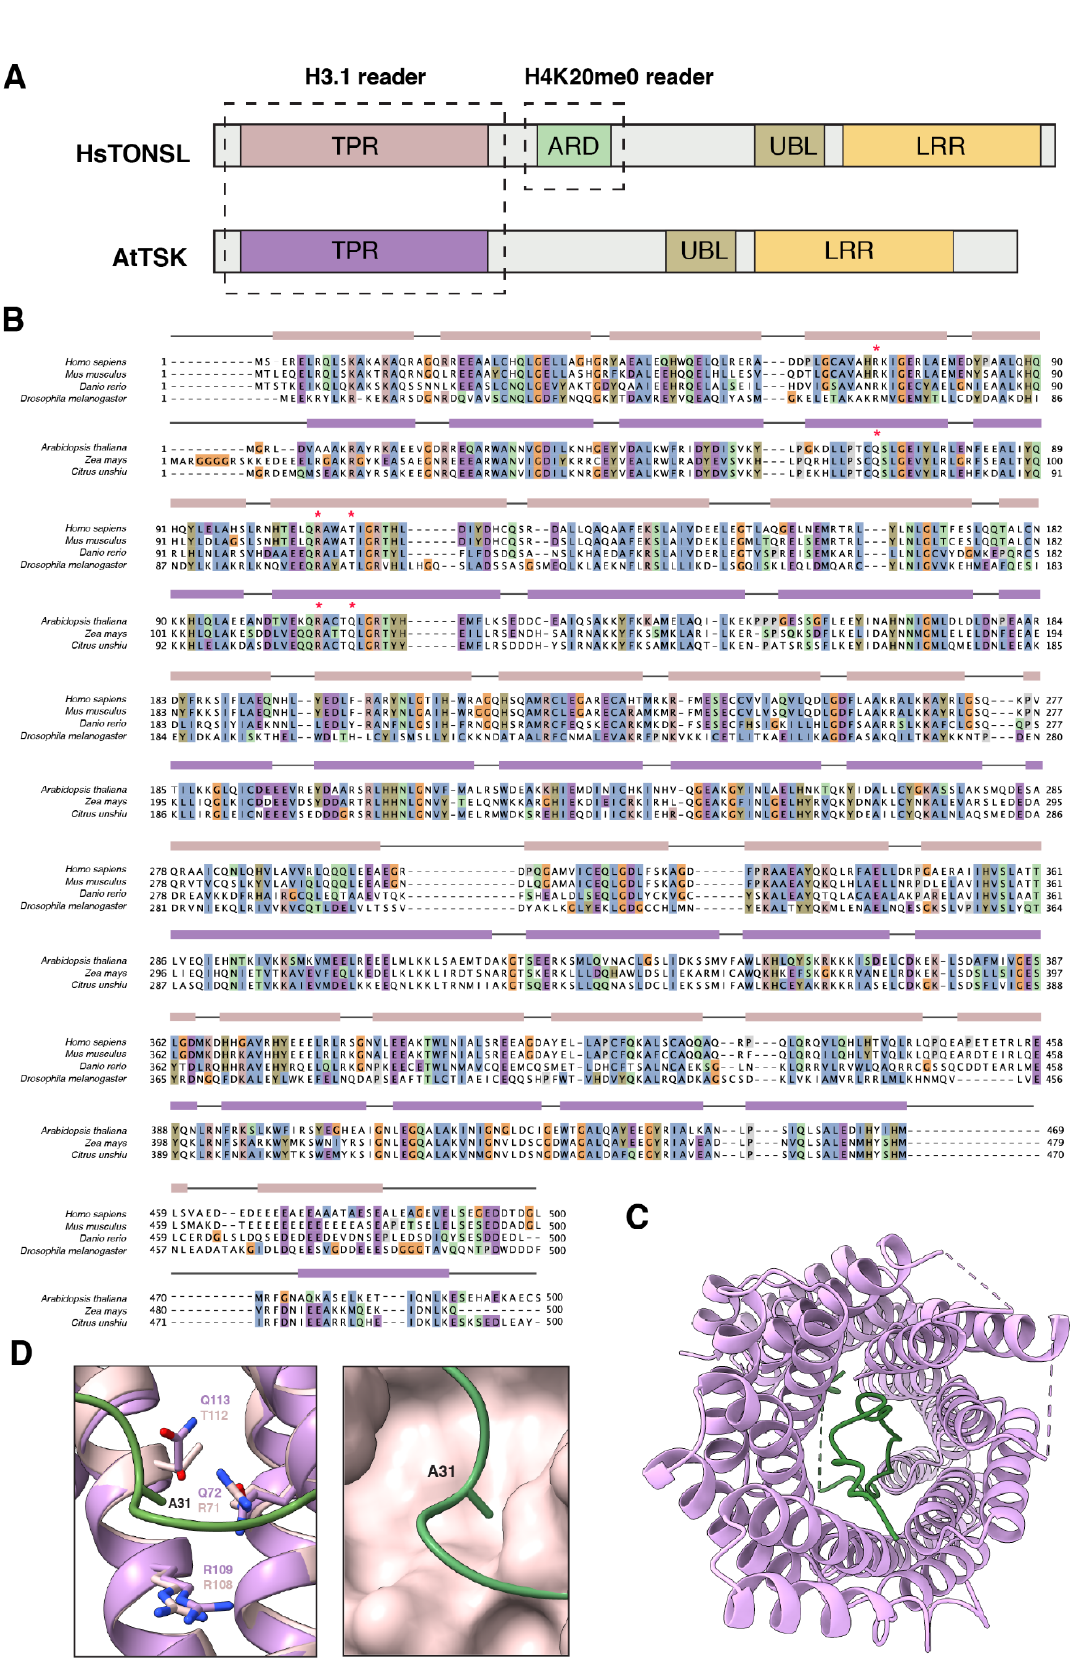
Figure 3. The TPR domain of TSK/TONSL functions as an H3.1 reader: ( A ) Domain architecture of human and Arabidopsis TONSL/TSK. TPR: tetratricopeptide repeats, ARD: ankyrin repeat domain, UBL: ubiquitin-like, LRR: leucine-rich repeats. The domains in TSK/TONSL responsible for binding